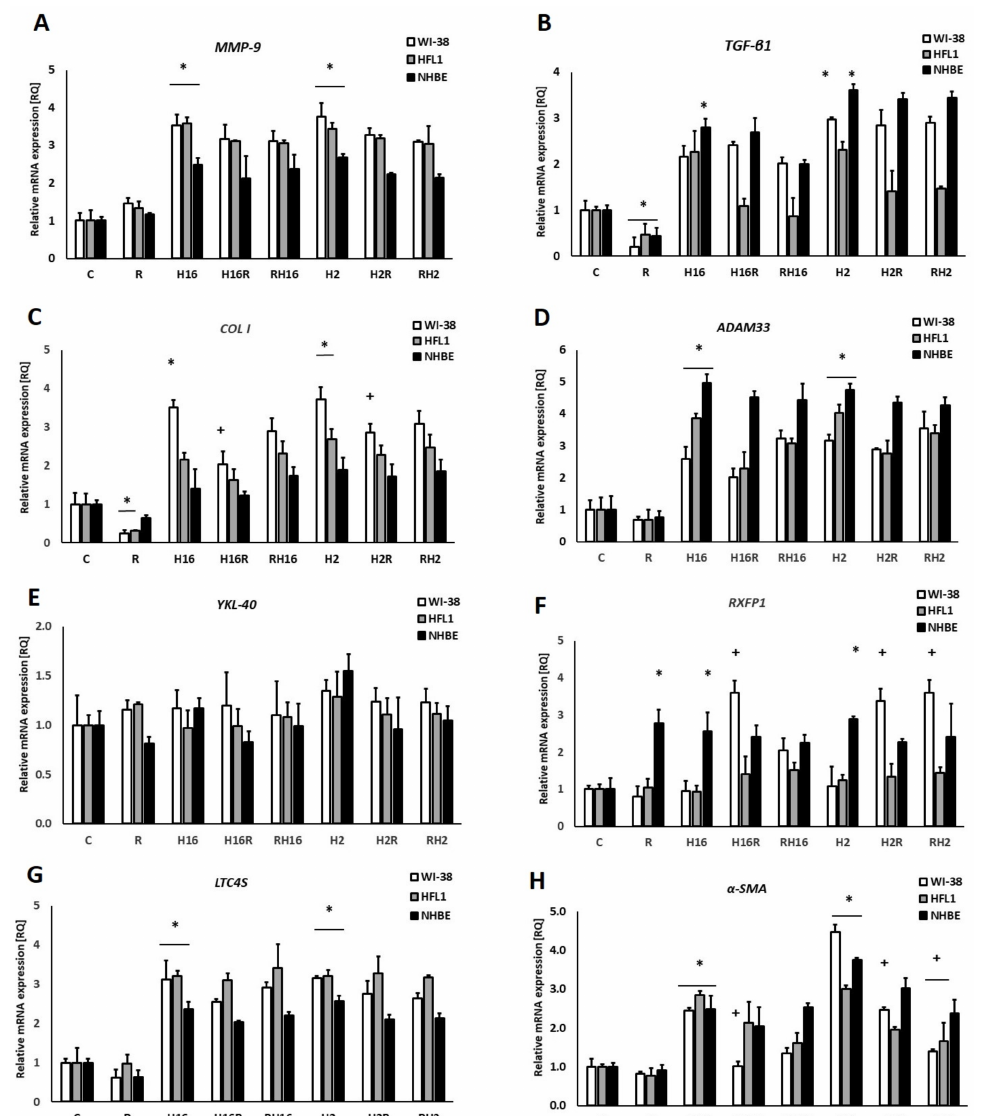
Figure 4. siRNA c-Myc knockout effect on Relaxin (R) in rhinovirus-infected cells. c-Myc transcription factor knockout inverted the relaxin (R) effect of a decrease in MMP-9 (Matrix metalloproteinase 9, ( A )) expression. TGF- β ( B ), and collagen I ( C ) mRNA expression was significantly decreased by relaxin. Under the conditions used, no effect of relaxin or rhinoviruses were observed in aDAM33 ( D ), YKL-40(Chitinase-3-like protein 1) ( E ) and LTC4S ( G ) expression. Relaxin changed the expression of RXFP1 in epithelial cells ( F ), and in fibroblasts in α -SMA ( H ). No difference was noticed between the specimens when relaxin was added to HRV (Human Rhinovirus)-infected cells (H16R, H2R) or prior to the HRV infection. H16R, H2R—rhinovirus 16 and 2 added first, followed by relaxin—after 24 h, as well as RH16, RH2—relaxin added first, followed by rhinovirus 16 and 2—added after 24 h. The data presented are normalized to the samples treated with control siRNA. * p < 0.05 in comparison to the control sample, and + p < 0.05 in comparison to the rhinovirus sample (HRV-2 or HRV-16, respectively); C is the control sample with medium only. N = 6, error